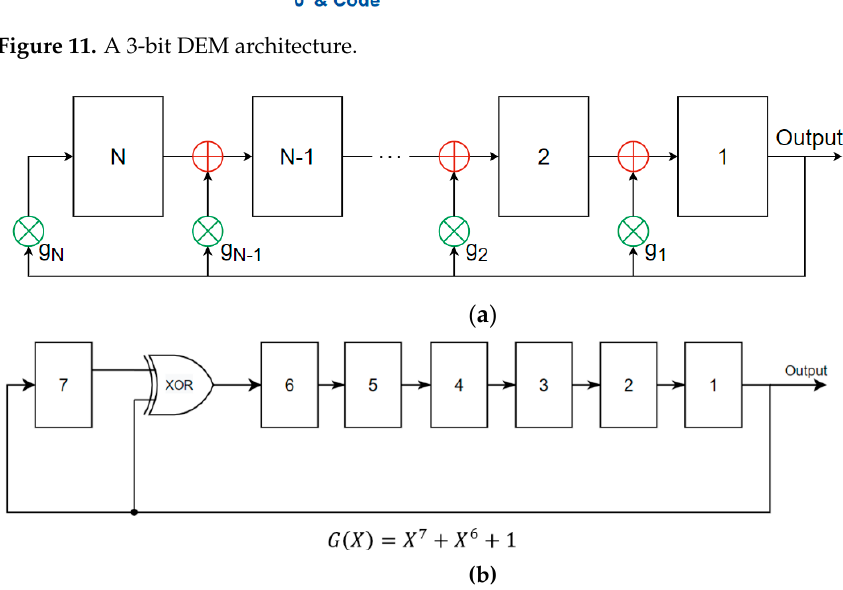
Figure 12. ( a ) Nth-order polynomial generation and ( b ) example of seventh-order polynomial implementation.